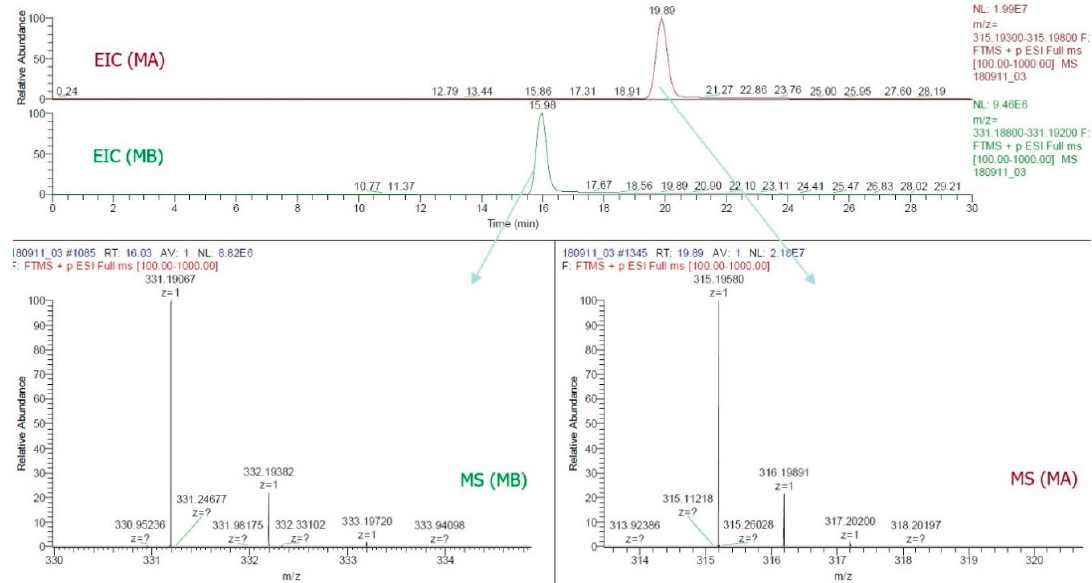
Figure 3. Extracted ion chromatograms and mass spectra of standard momilactones A and B.